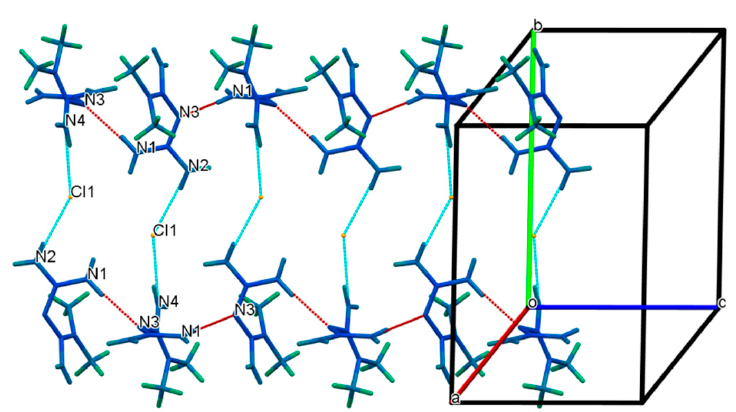
Figure 10. Hydrogen bonded two-dimensional layered structure of MET·HCl.